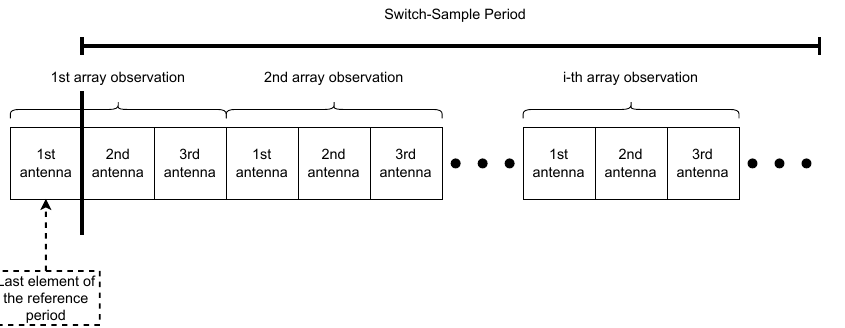
Figure 5. Example of the Round Robin switch pattern of a L-shaped array with three antennas. Only the sample slots are